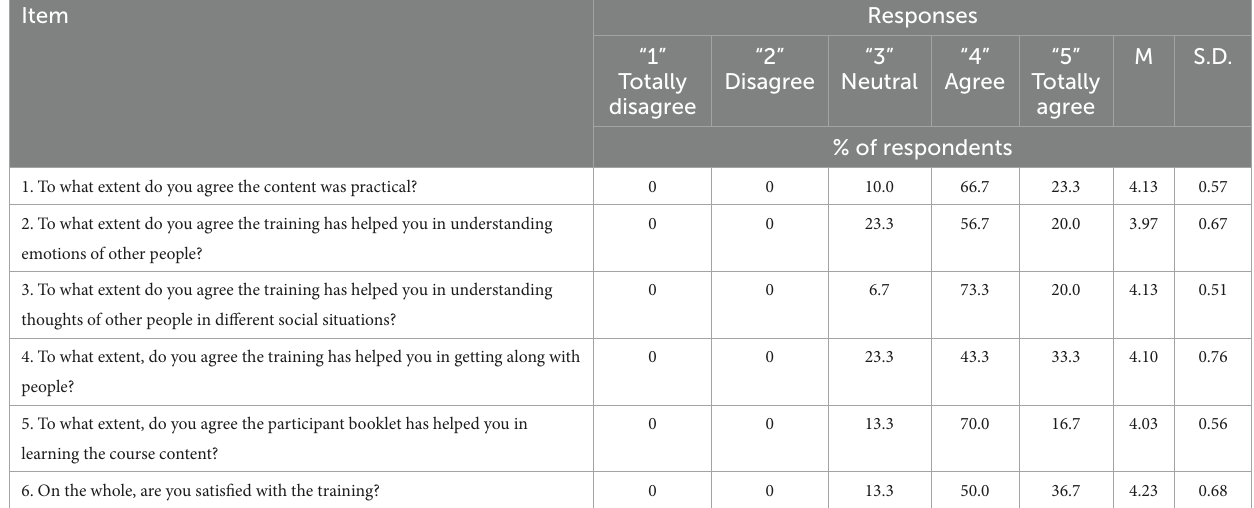
TABLE 2 Feedback on SCIT from participants.